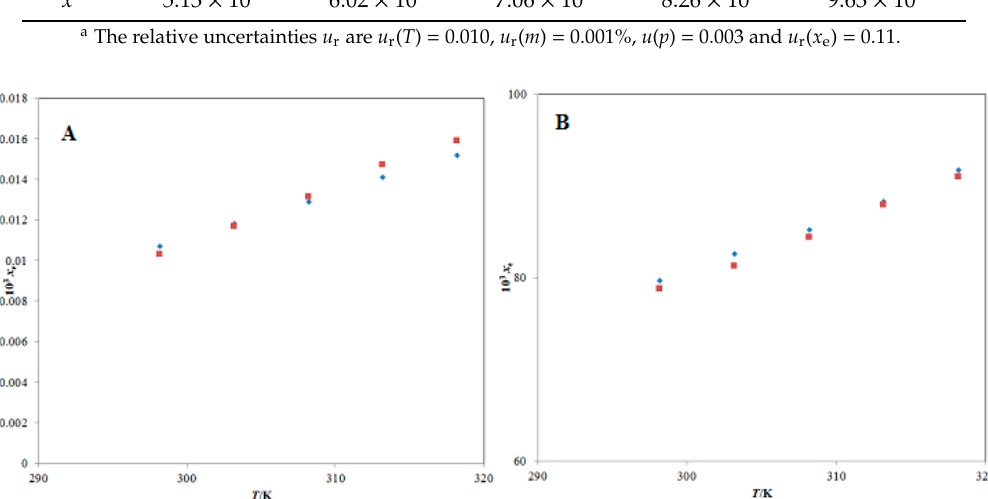
Table 1. Experimental solubilities ( x e ) of piperine (PPN) in mole fraction in di ff erent “Transcutol-HP (THP) + water” mixtures ( m ) at “ T = 298.2–318.2 K” and “ p = 0.1 MPa” a . m T = 298.2 K